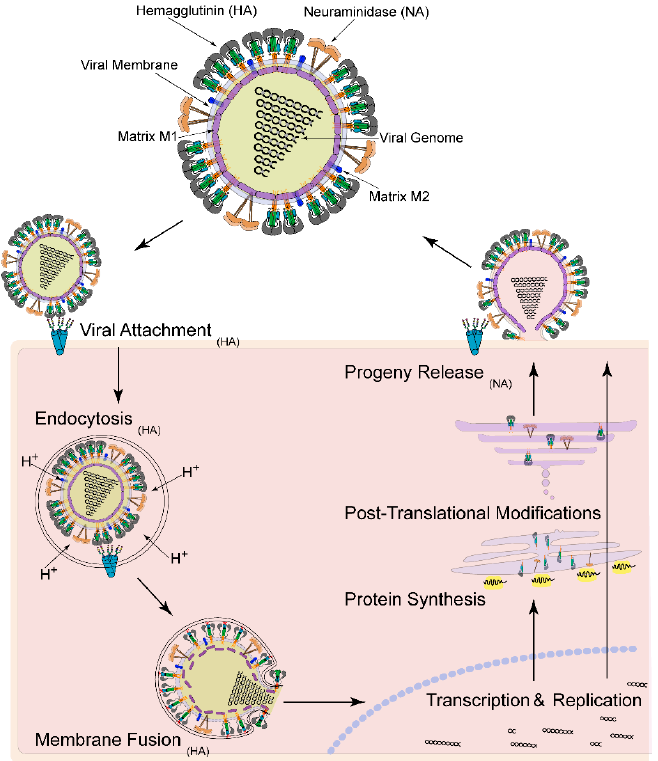
Figure 1. Influenza virus structure and infectious cycle. Viral attachment is mediated by Hemagglutinin (HA), which bind through multi-valent, high avidity interactions to host cell surface glycans, triggering endocytosis of the virus particle. Following acidification of the endosomal lumen, M1 dissociates from the inner surface of the viral membrane, and HA undergoes large structural changes to drive membrane fusion ultimately releasing the nucleoprotein-coated genome segments into the cytosol, which is transported to the nucleus for genome transcription and replication. Viral proteins are synthesized and post-translationally modified via the endoplasmic reticulum and trans-golgi network. Progeny viruses are assembled at the cell surface, where Neuraminidase (NA) cleaves neighboring sialic acid for release of newly formed virus into the extracellular milieu.